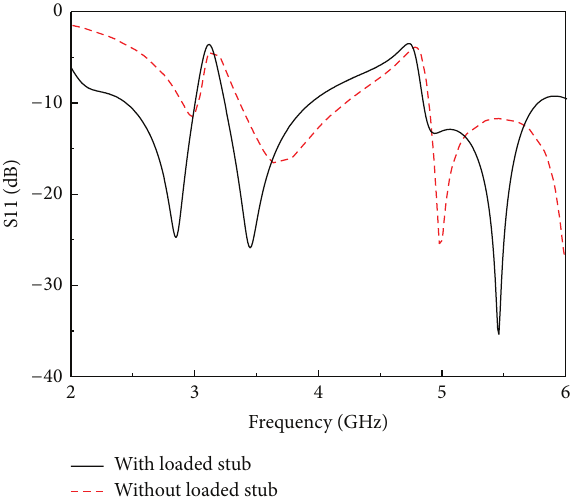
Figure 5: The simulated return loss of the two